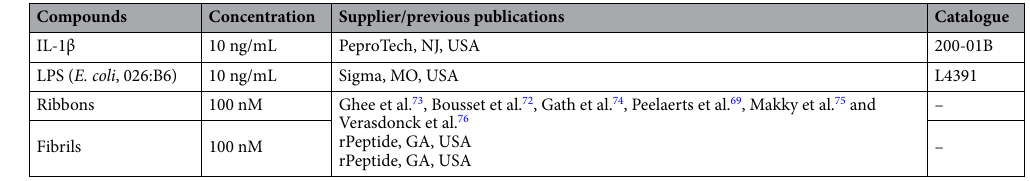
Table 1. α-Synuclein and cytokine